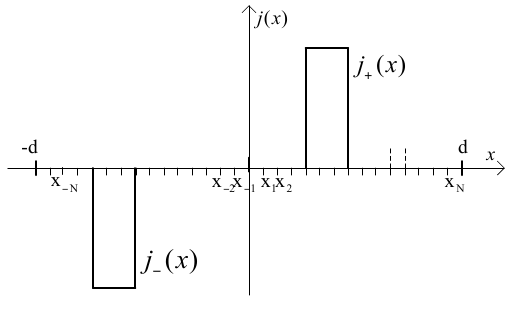
Figure 6. Equivalent 1D problem of magnetic field